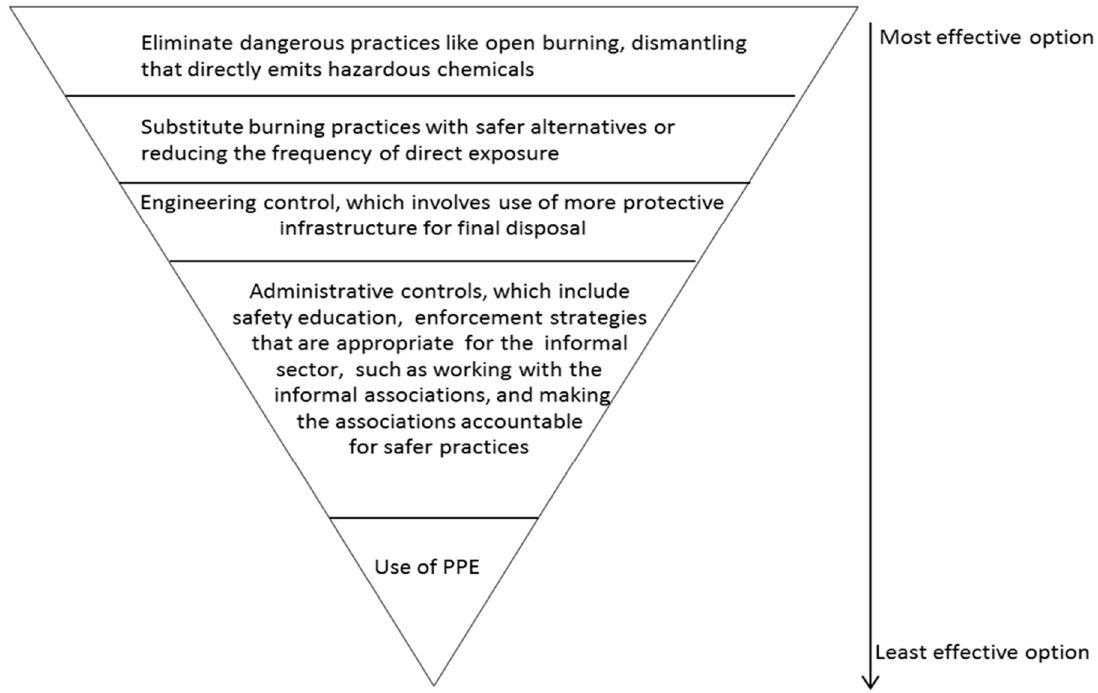
Figure 10. Hierachical control at the informal e -waste recycling sites; modified from OSHA 2016, [64].